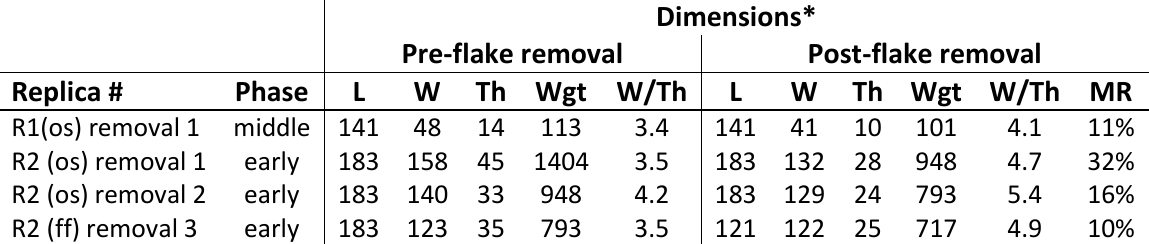
Table 1. Dimensions and proportions of bifaces before and after flake removals. Abbreviations: os = overshot; ff = full face. L = length; W = width; Th = thickness; Wgt = weight; MR = mass reduction; * all dimensions taken on the flake removal